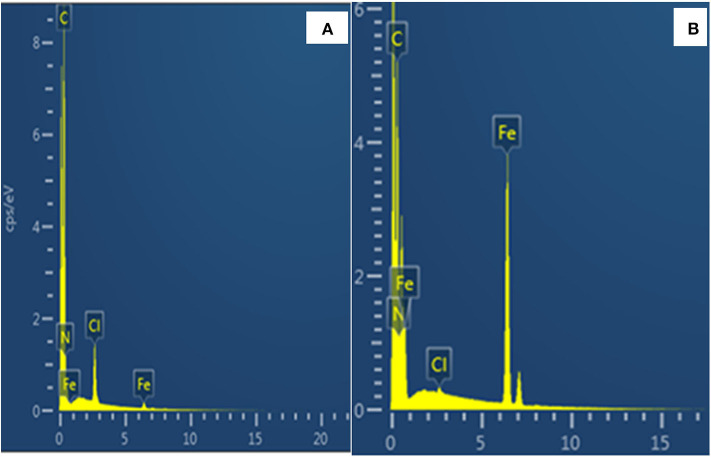
EDS spectra of (A) P-POP and (B) MP-POP.